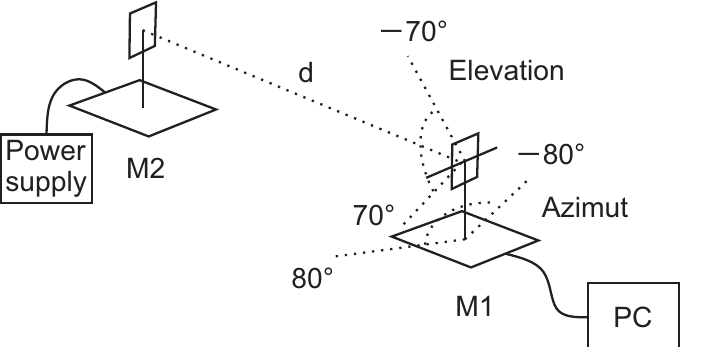
Figure 5. Setup for training-data measurements with module M2 on a stand and module M1 on a stand with the gimbal. For M1, the range of motion for the elevation was from − 70 to 70 degrees and for azimuth, from − 80 to 80